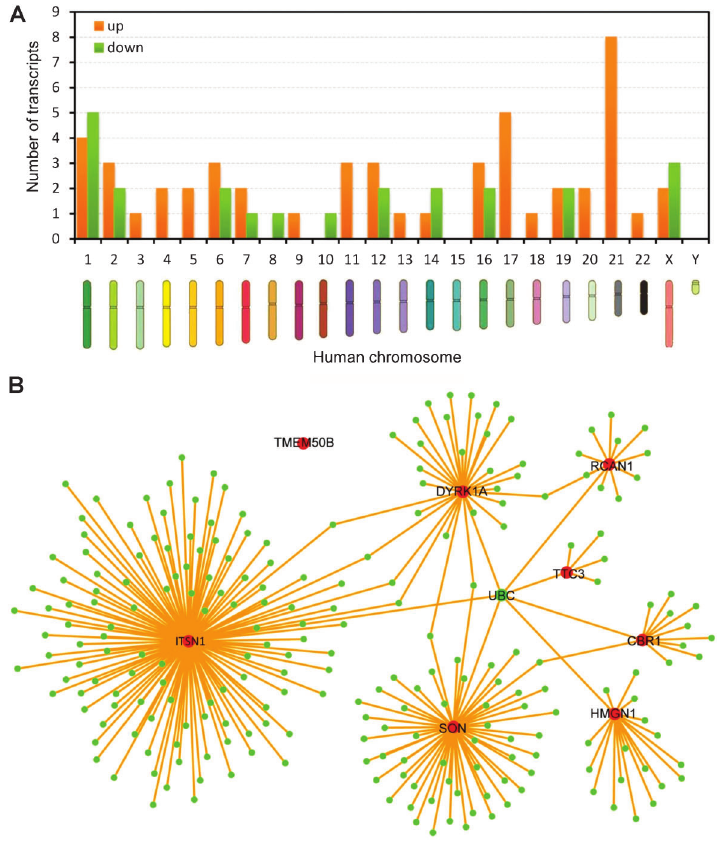
Figure 2. A , Distribution of homologous gene transcripts in both human and mouse in the human chromosome. B , Interaction networks of eight genes in chromosome 21. Rednodes repre- sent differentially expressed genes (DEGs), and green nodes represent non-DEGs.